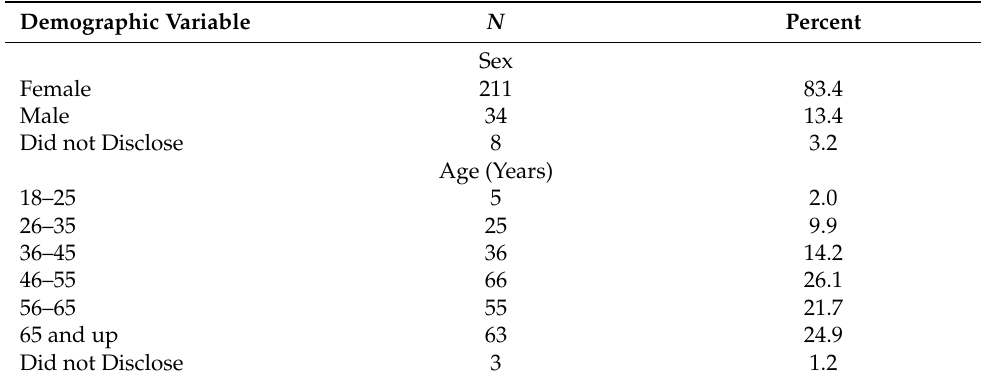
Figure 1. Survey flow with associated participant sample size. Survey sections with associated num- ber of participants who completed each section. Gray boxes are questions that incorporated Qualtrics’ piped text (i.e., dog’s name) or display logic (i.e., Did they discuss the results with someone?). Table 1. Participant self-reported sociodemographic